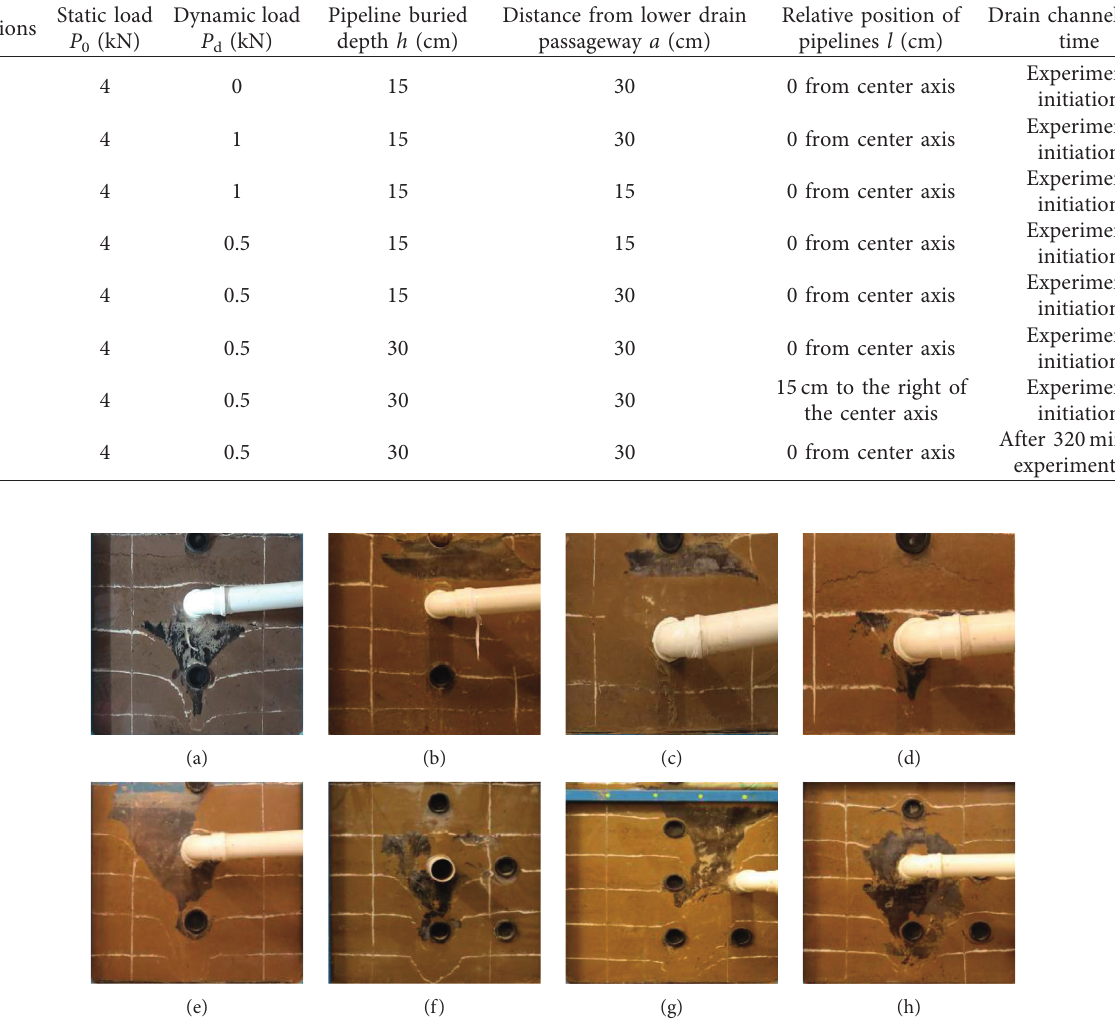
Figure 4: Final failure pattern. (a) Condition 1. (b) Condition 2. (c) Condition 2. (d) Condition 4. (e) Condition 5. (f) Condition 6. (g) Condition 7. (h) Condition